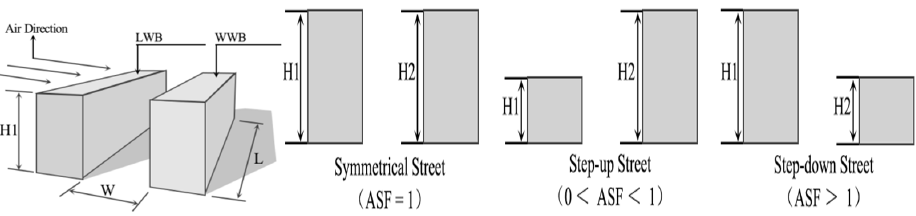
Figure 3. Typical urban street canyon model.